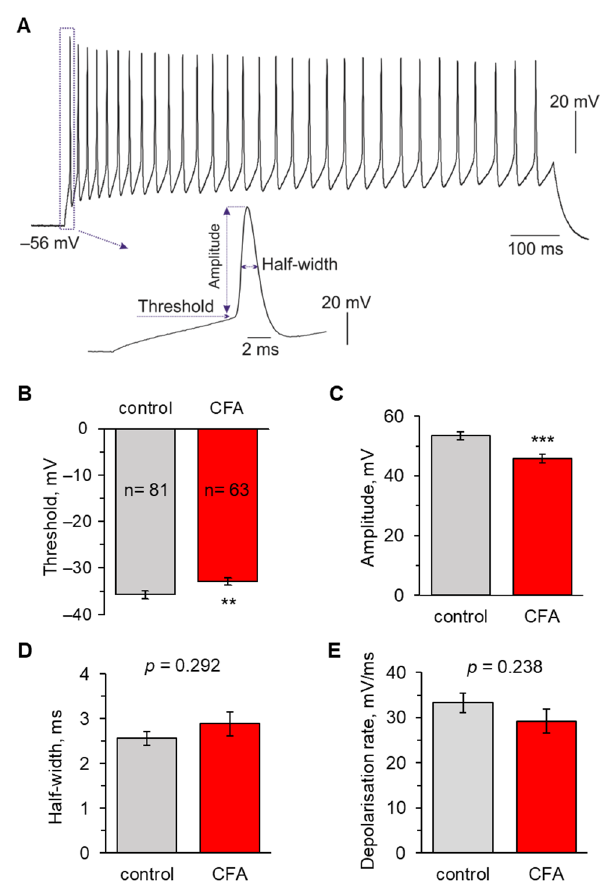
Figure 1. Peripheral inflammation increases the DH neuronal excitability. ( A ) An example of a current-clamp recording of neuronal firing (top) and analysis of the first action potential (AP) in the pulse train (bottom). ( B ) Statistical summary revealed a depolarising shift in the threshold of APs in DH neurons at 1 d post ‐ CFA. ( C ) Analysis of APs showed a decreased amplitude in DH neurons at 1 d post ‐ CFA. ( D,E ) Statistical summary of the kinetics of APs generated by DH neurons showed no inflamed groups. All data are mean with SEM; the number of recorded cells per group is